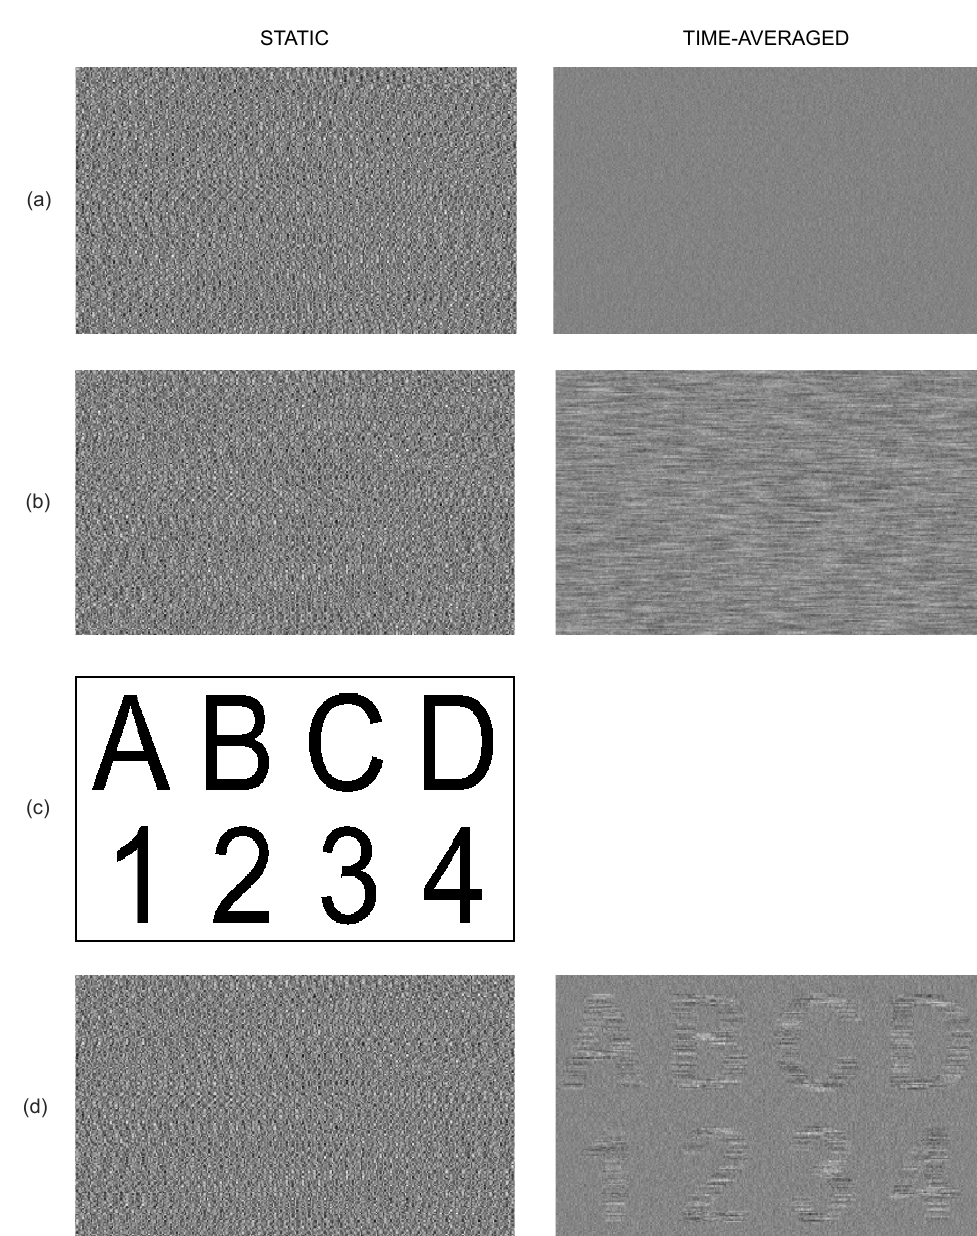
Figure 7. The DVC scheme based on the stochastic moiré gratings. The resolution of the cover image is set to 300 × 180 pixels; 180 copies of non-identical near-optimal one-dimensional moiré gratings M 1 ( x ) constitute the static image in panel ( a ). The time-averaged image M 1 ( x ,5 ) yields an almost plain gray image (panel ( a )); 180 copies of non-identical near-optimal one-dimensional moiré gratings M 2 ( x ) constitute the static image in panel ( b ). The time-averaged image M 2 ( x ,5 ) in panel ( b ) is very different from M 1 ( x ,5 ) in panel ( a ). The dichotomous secret image is depicted in panel ( c ). The static cover image containing the embedded secret is shown in panel ( d ). The time-averaged image of the cover image yields the